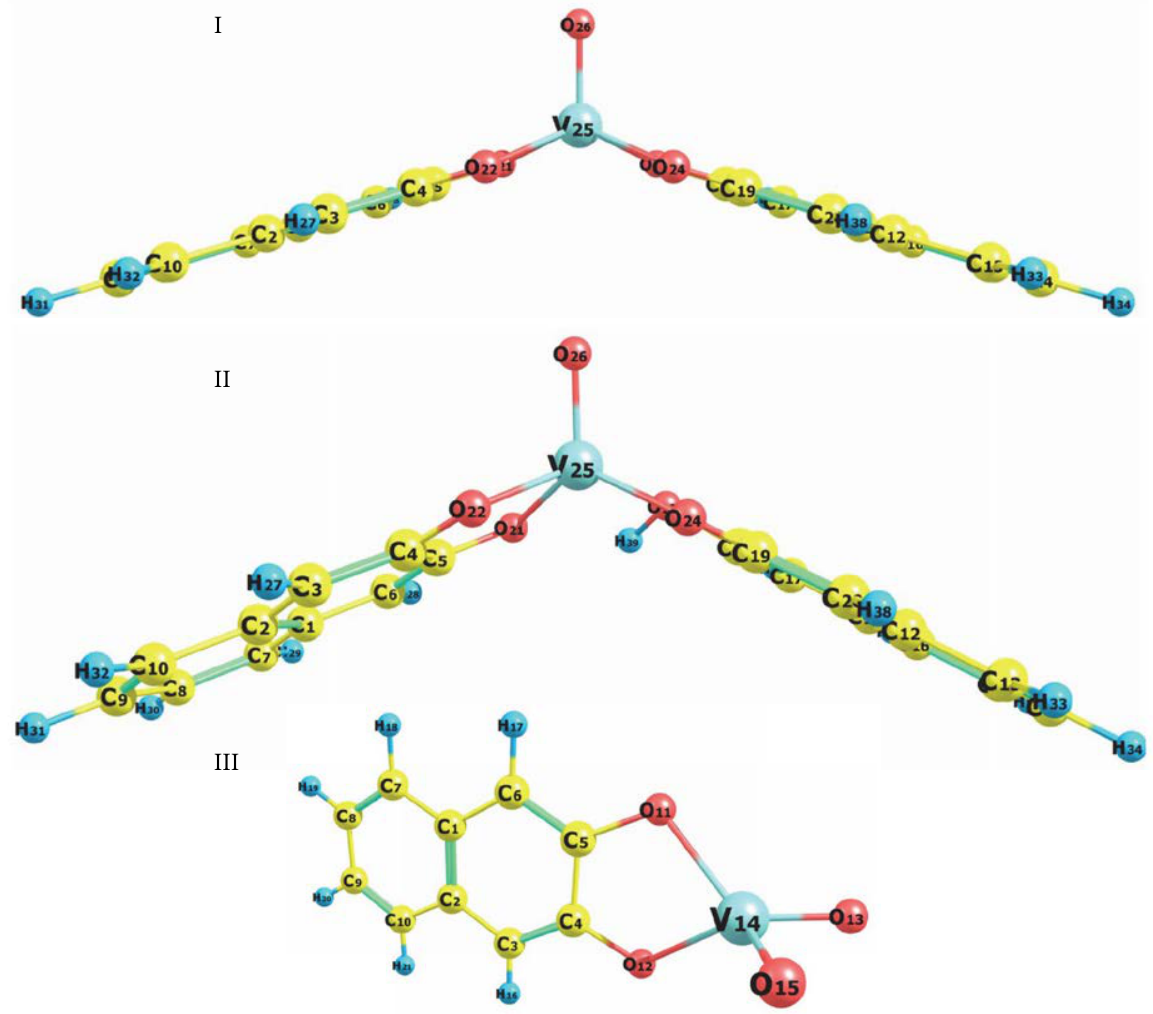
Figure 7. The optimized ground-state geometry of [V IV O(DN 2− ) 2 ] 2− ( I ), [V IV O(DN 2− )(DNH) − ] − ( II ) 21 and [V V O 2 (DN 2− )] − ( III ).